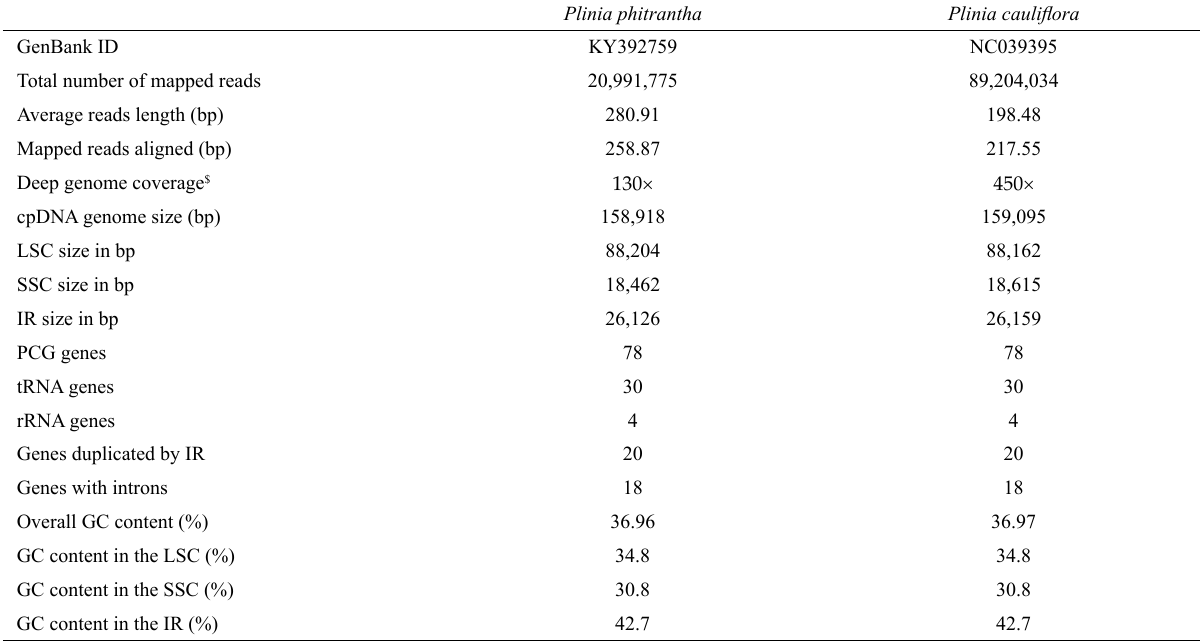
Table 1 – Summary of the characteristics of the plastid genomes newly sequenced in this